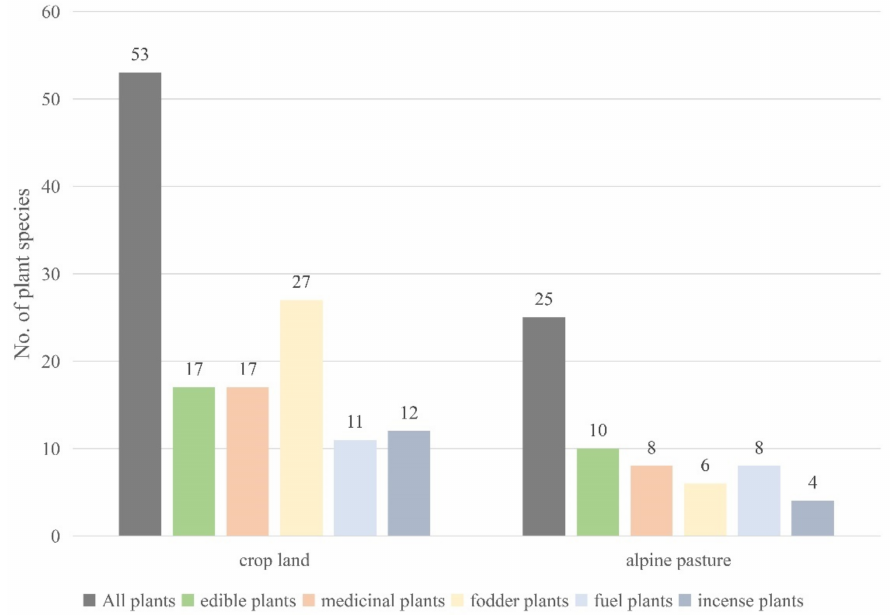
Figure 3. Collection sites of all used plants, including edible, medicinal, fodder, fuel, and incense plants in the study area.